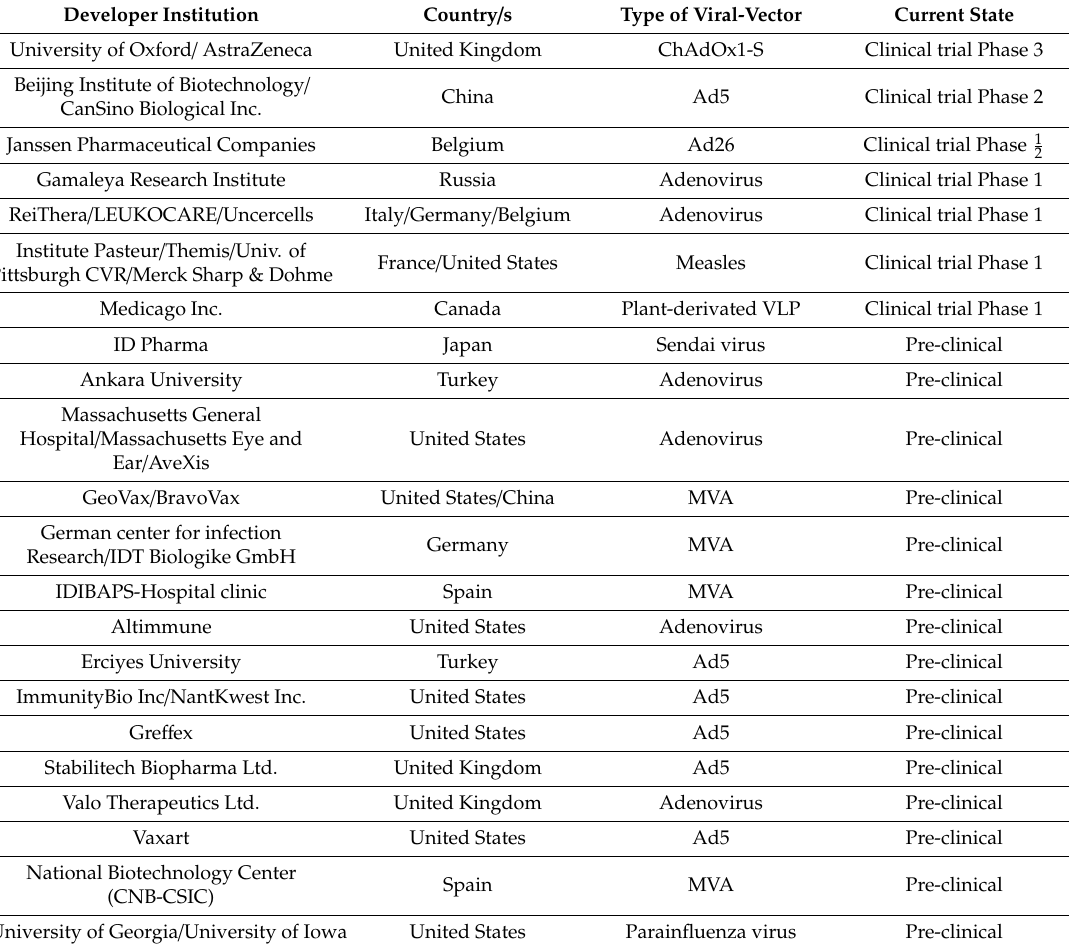
Table 1. Viral-vector vaccine candidates and their current state of development according to the